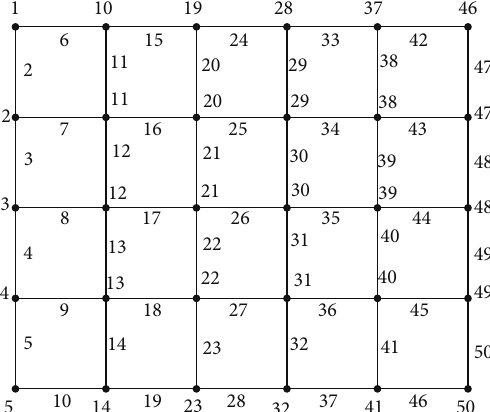
Figure 4: A C -exponential mean labeling of P